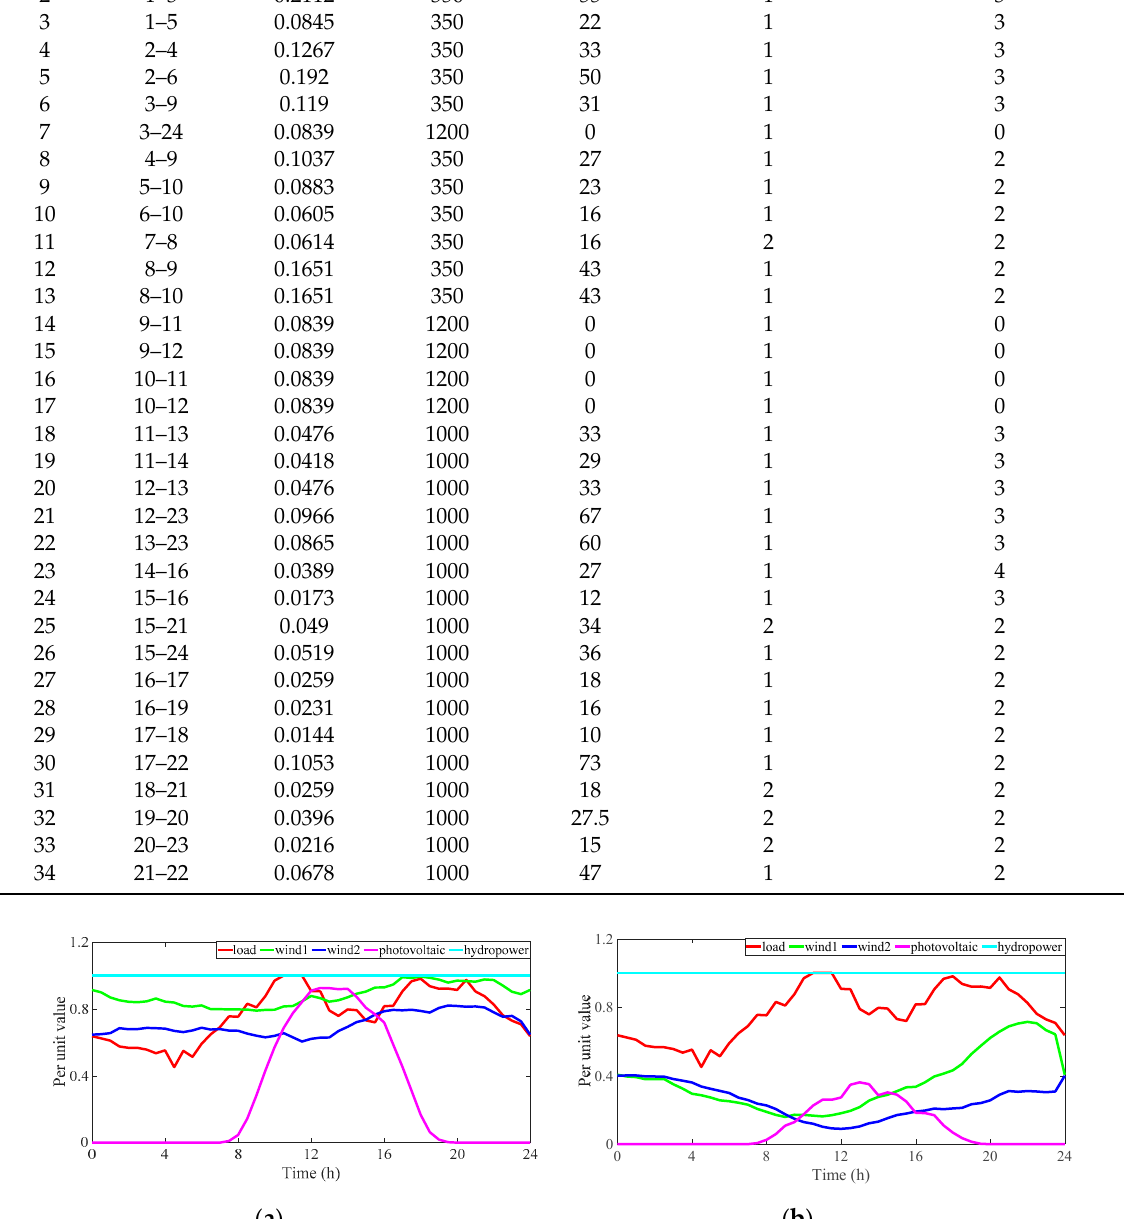
Figure A2. Typical load and wind power planning scenarios. ( a ) Scenario 1, occurrence probability: 0.4603; ( b ) Scenario 2, occurrence probability: 0.5397.